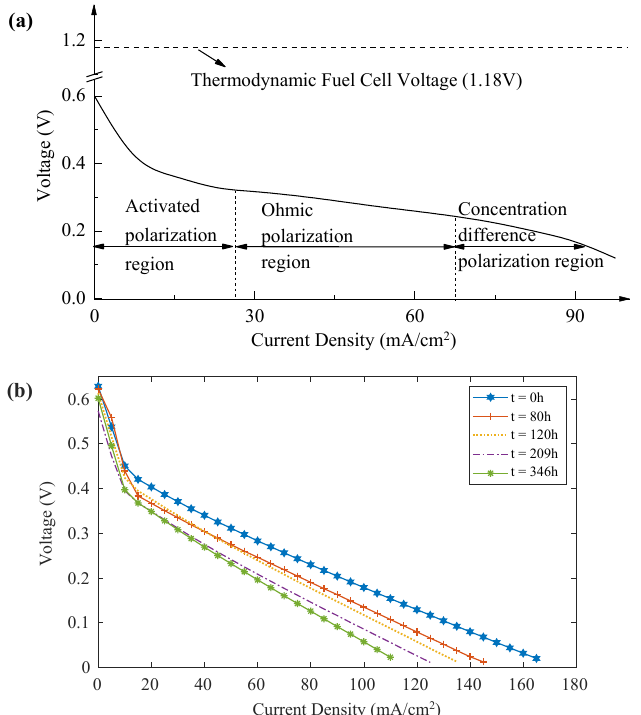
Figure 3. Polarization curves: ( a ) A typical polarization curve of µ DMFC; ( b ) Measured polarization curves at different